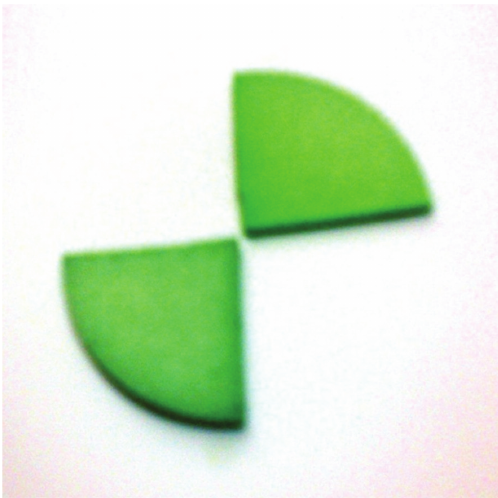
Figure 3: Pieces of absorption paper showing homogenous spread of chromium standard.